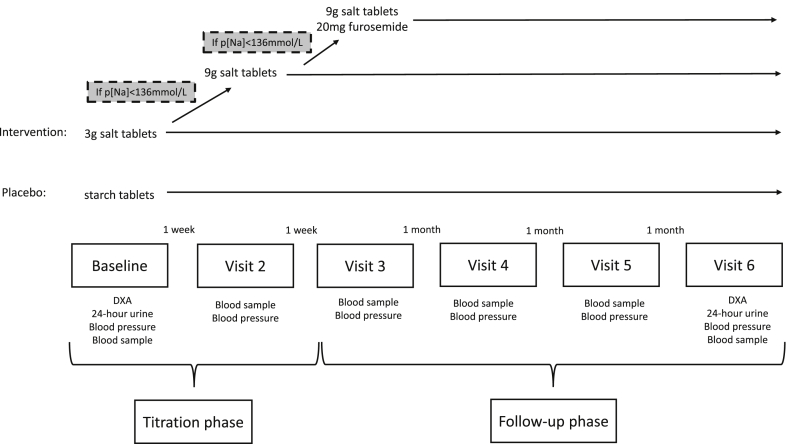
Illustration of the experiment outline. Dual Energy X-ray Absorptiometry (DXA) scan.